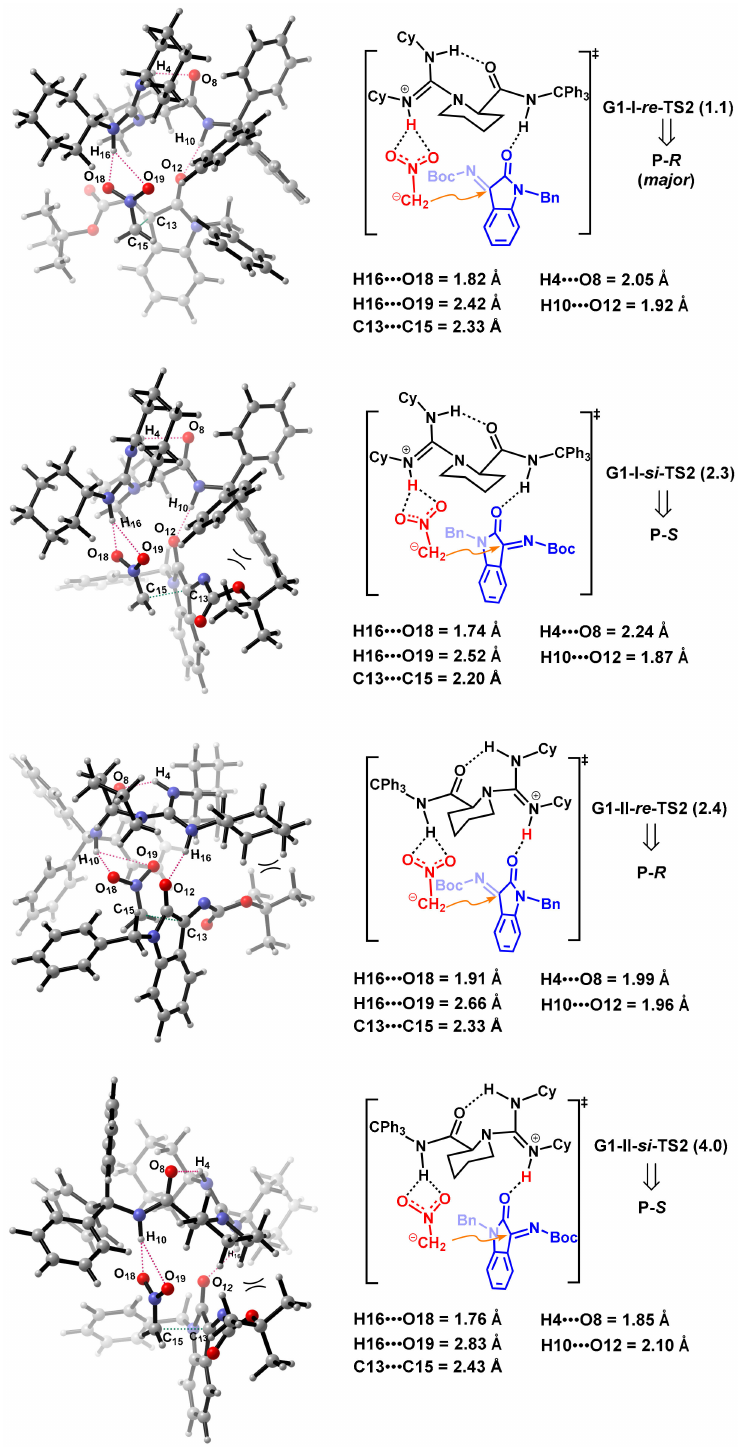
Figure 4. Optimized geometries of four transition states along re - or si -face attack pathways. The relative Gibbs free energies are given in kcal · mol − 1